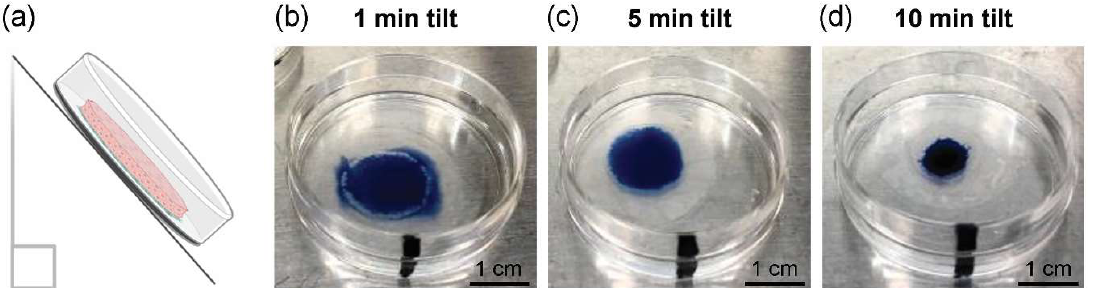
Figure 2. Single layer cell sheet surface interaction optimization. To remove excess interfacial culture medium without drying cell sheets, ( a ) cell sheets on insert membranes/TCP dishes were tilted upright at an approximate 45 angle for ( b ) 1 min, ( c ) 5 min or ( d ) 10 min. Scale bars = 1.0 cm.